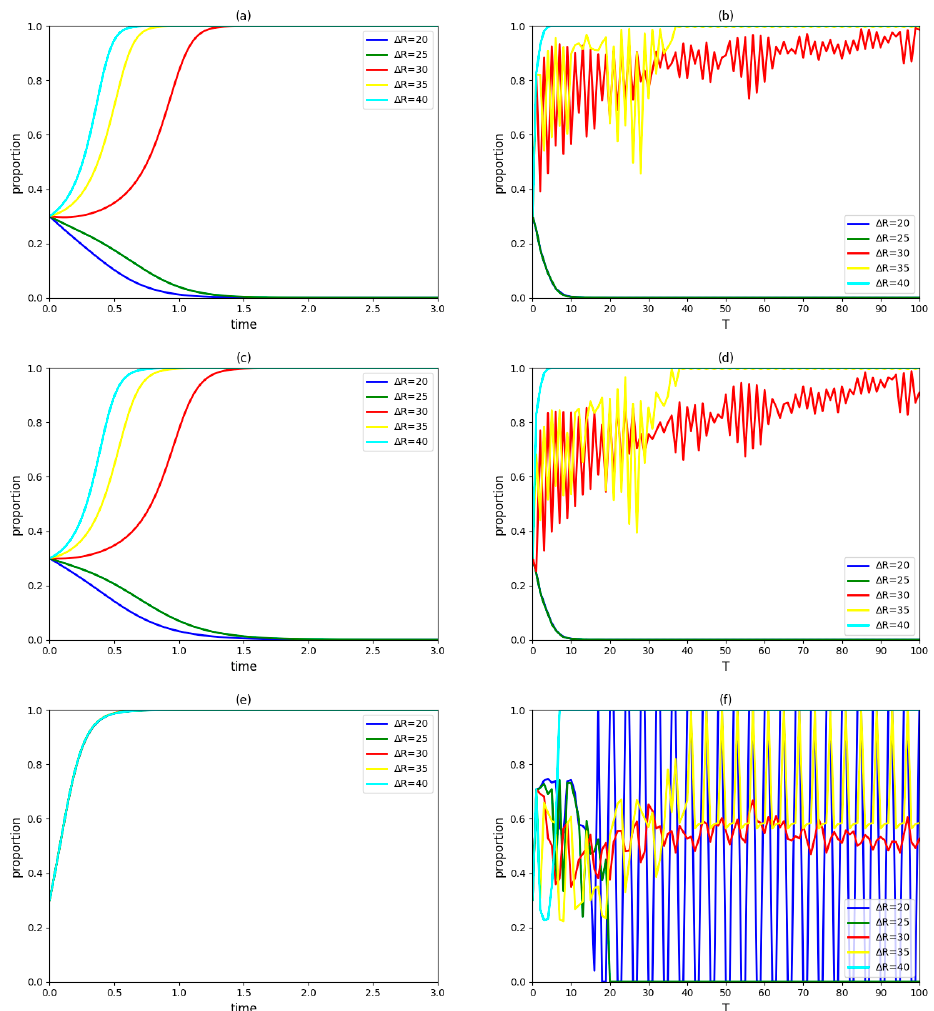
Figure 1. ( a ) The evolutionary paths of enterprise strategies with different cooperative innovation revenues. ( b ) The proportion of cooperative enterprises in the region over time. ( c ) The evolutionary paths of university/institute strategies with different cooperative innovation revenues. ( d ) The proportion of cooperative universities/institutes in the region over time. ( e ) The evolutionary paths of the government strategies with different cooperative innovation revenues. ( f ) The implementation of the proportion of the government adopting a participation strategy in the region over time .